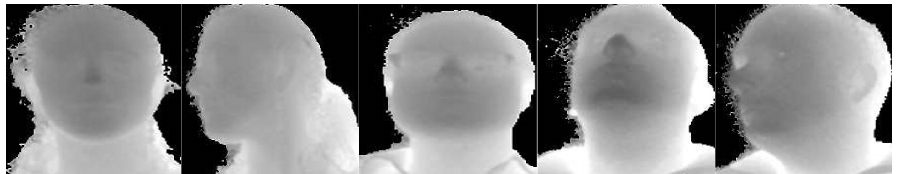
Figure 5. Sample depth images from the High-Resolution Range-based Face Database (HRRFaceD) dataset. As shown, heads were acquired under different